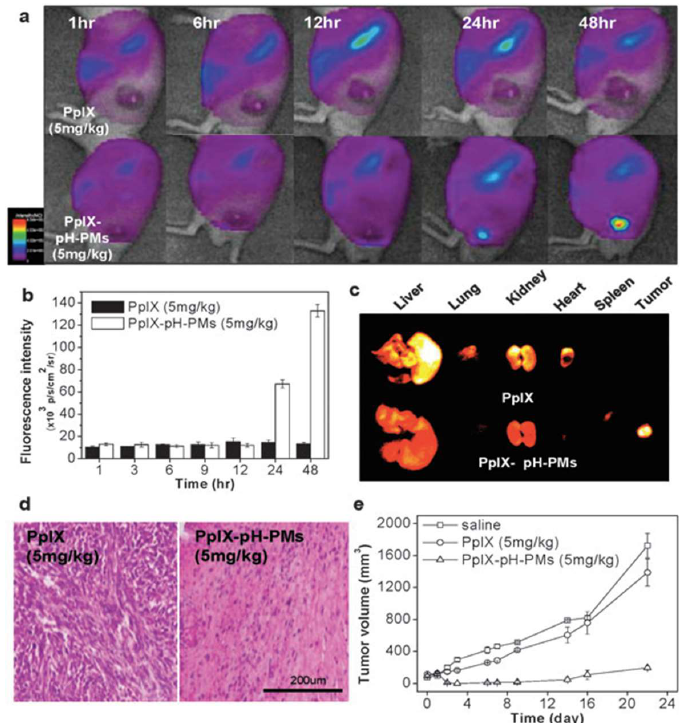
Figure 3. Non-invasive fluorescence imaging and photodynamic therapy (PDT) with PpIX-pH-PMs in live SCC7 tumor-bearing mice. In vivo time-dependent whole body imaging after injection ( a ); in vivo quantification of tumor target specificity of free PpIX and PpIX-pH-PMs ( b ); ex vivo images of organs (liver, lung, spleen, kidney, heart) and tumors ( c ). ( d ) H&E staining of tumor tissues 10 days after treatment. ( e ) Tumor growth of SCC7 tumor-bearing mice treated with drug injection and irradiation. Results represent means ± SDs. ( n = 2). Reproduced from Reference [37] with permission from the Royal Society of Chemistry, 2010.